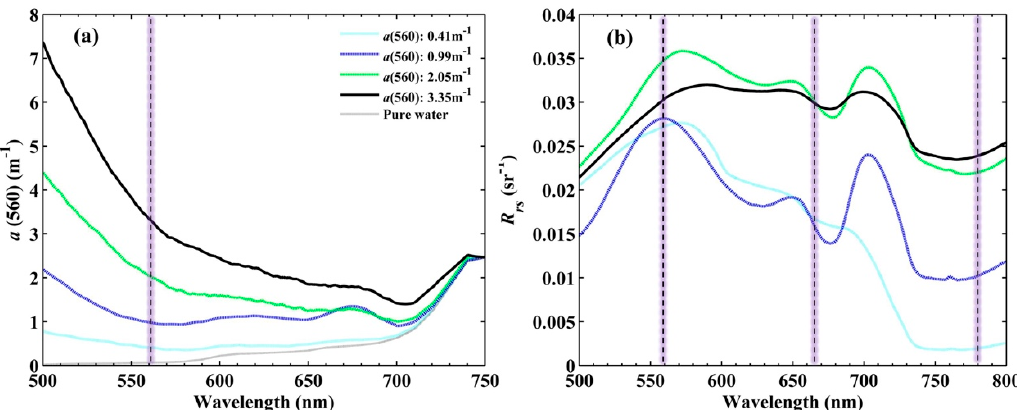
Figure 4. Examples of ( a ) a (560) and corresponding ( b ) R rs spectrum at different locations.